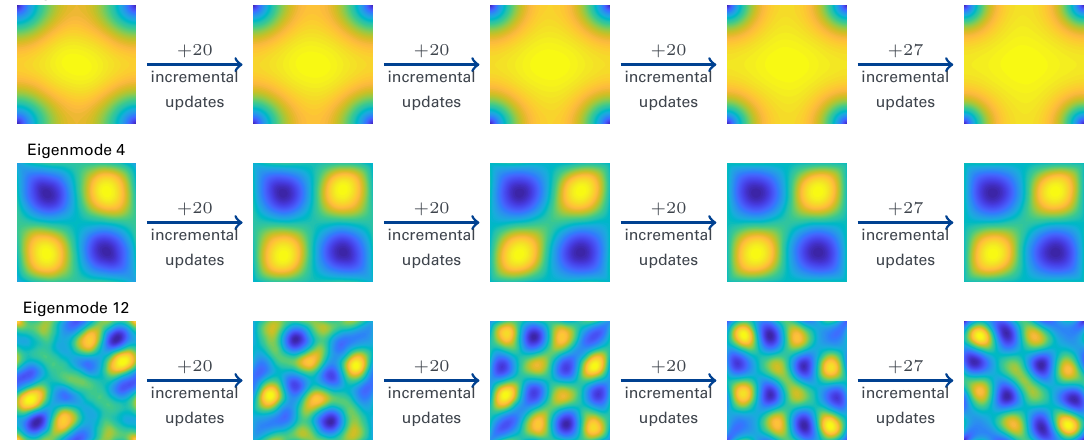
Figure 8. The development of a few selected eigenmodes over the enrichment are shown for the circular inclusion morphology. Note that these results are generated with n a = 15 and ε = 0.01 using Method C. The procedure comprised a total of 87 basis